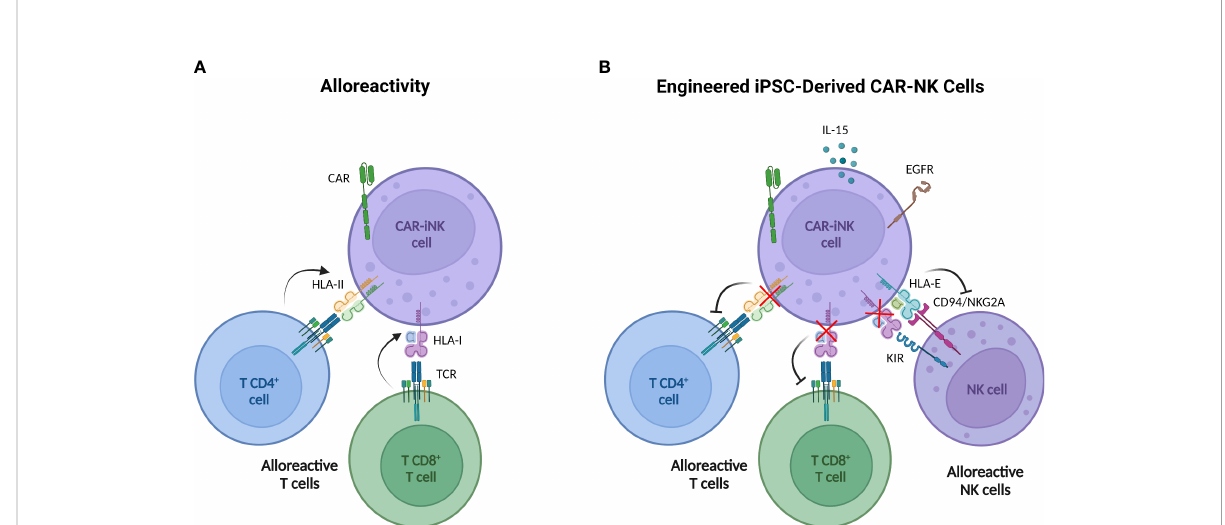
FIGURE 2 Multi-engineered iPSC-derived CAR NK cells designed to overcome T cell alloreactivity. (A) iPSC-derived CAR NK cells may be rejected by host alloreactive T cells due to the recognition of non-self HLA I by CD8+ T cells and HLA II by CD4+ T cells. (B) Engineered iPSC-derived CAR NK cells incorporate six modi fi cations through three gene-editing steps. 1) The b -2-microglobulin ( b 2M) disruption to avoid HLA-I expression with the simultaneous insertion of a transgene encoding HLA-E protein (tethered with b 2M and a peptide) impedes NK cell killing activity by “ missing-self ” recognition. 2) The CIITA knock-out to deplete the HLA-II expression concurrently with knock-in of the epidermal growth factor receptor (EGFR) safety switch and the interleukin 15 (IL-15). Safety switch strategy allows the elimination of iPSC-derived CAR NK by the administration of anti-EGFR antibodies and IL-15 secretion improves cell persistence. 3) CD19 CAR knock-in. Created with